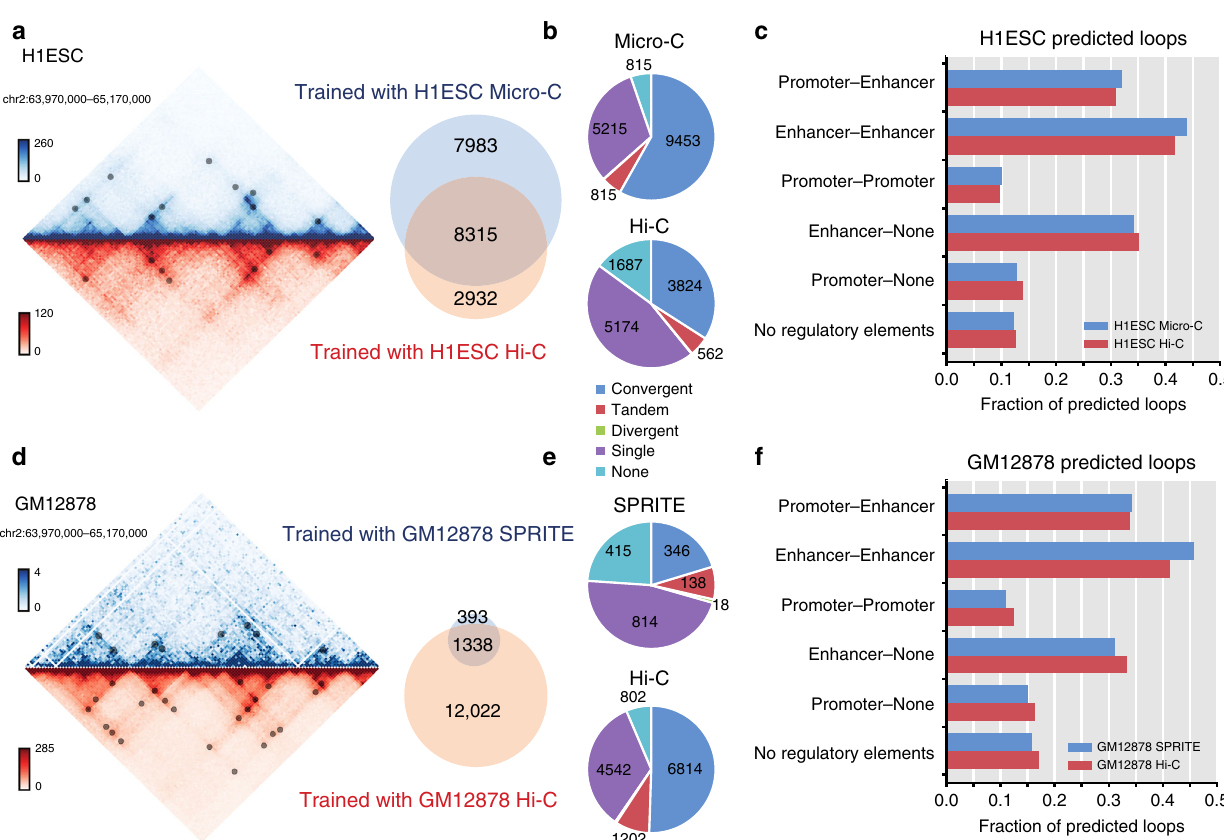
Fig. 6 Cross-platform comparison of Peakachu loops in different tissue types. a Overlap of loops predicted in H1ESC by Micro-C and Hi-C, using the same CTCF ChIA-PET training set. b Patterns of CTCF binding site orientations in predicted loops. c Regulatory elements at anchor loci of predicted loops. d – f Repeat analysis comparing DNA SPRITE with Hi-C in GM12878, using the same CTCF ChIA-PET training set. Source data are available in the Source Data fi